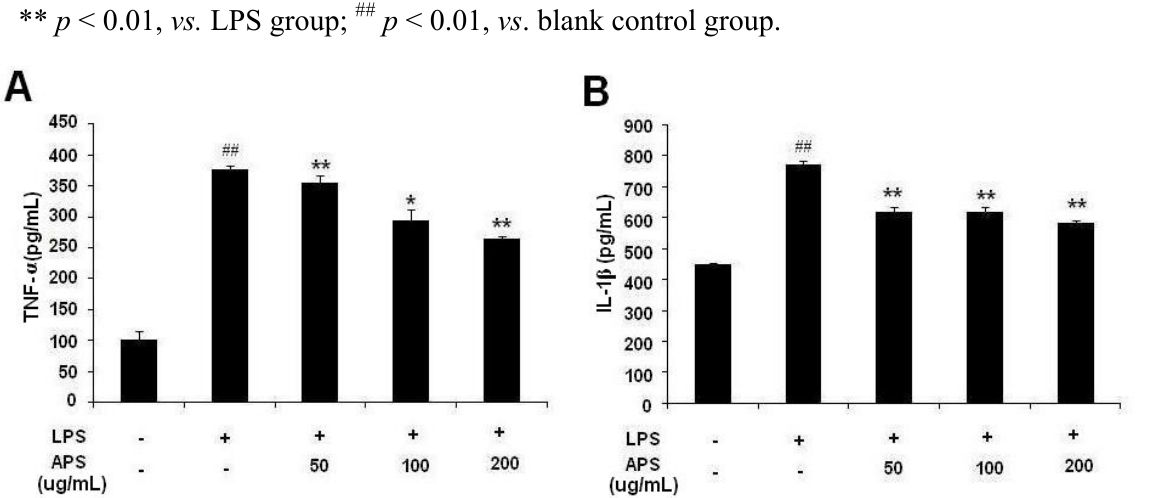
Figure 2. APS inhibited LPS-induced TNF-  and IL-1 β production in THP-1 cells. ( A ) Level of TNF-  in culture supernatant of THP-1 cells; ( B ) Level of IL-1 β in culture supernatant of THP-1 cells. Data are the means ± S.D. of three independent experiments. * p < 0.05,